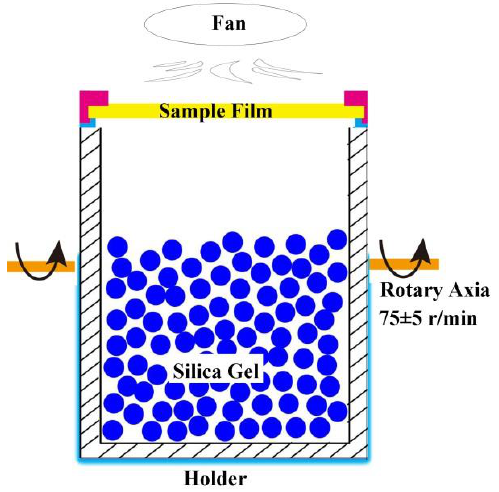
Scheme 2. Schematic diagram of the water–vapor transmission